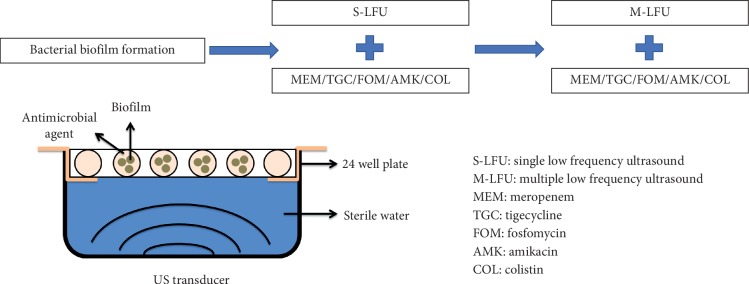
Diagram depicting using LFU and antimicrobial agents for the treatment of K. pneumoniae biofilms. Three catheter disks with biofilms were placed into each well of a 24-well plate containing 1 mL of antimicrobial agent solution. Sterile medium was added to the wells around the edge of the 24-well plate, serving as a negative control. LFU was transmitted through the bottom of the plate via sterile water. This study was to investigate the treatment effect of S-LFU or M-LFU in combination with five different types of antimicrobial agents.